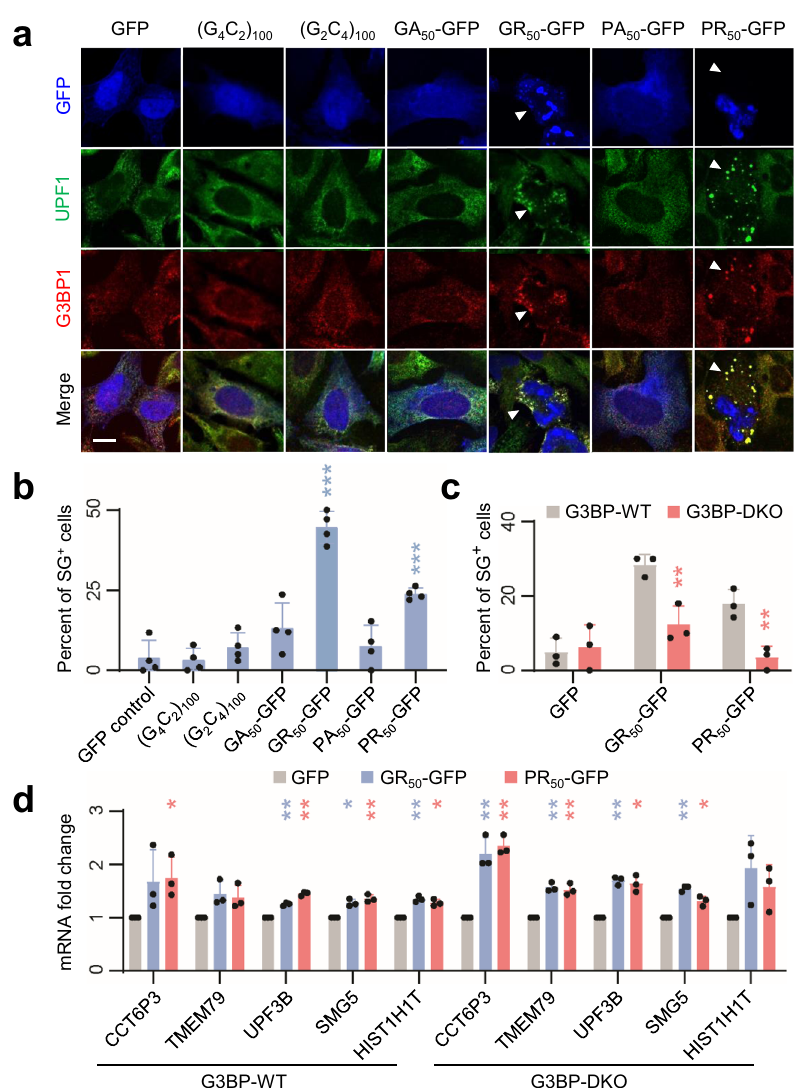
Fig. 3 Recruitment of UPF1 to stress granules is independent of NMD inhibition. a UPF1 and G3BP1 localization in HeLa cells expressing either GFP only, repeat RNA, or GFP-tagged DPR. Stress granules are indicated by arrowheads. Scale bar, 10 µ m. Similar results were obtained from four independent experiments. b Quanti fi cation of stress granule (SG)-positive cells. n = 4 independent experiments. Data are presented as mean values ± SD. *** P <